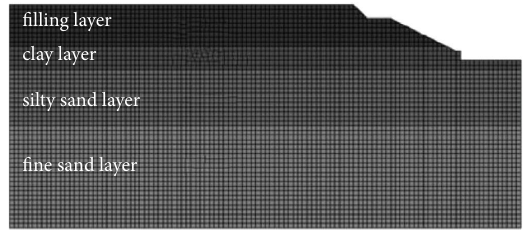
Figure 7: Distribution grid of each soil